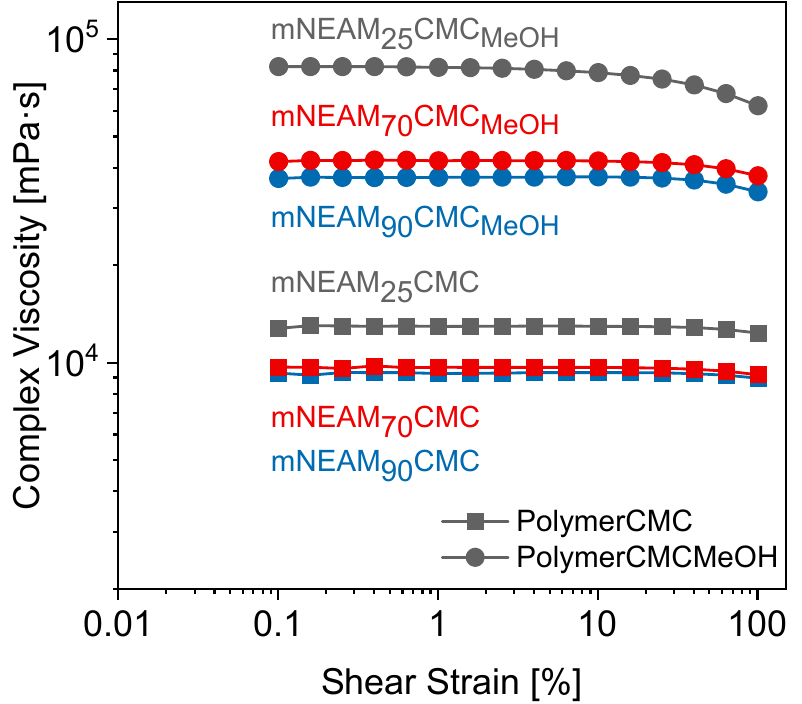
Figure 6. Complex viscosity as a function of shear strain (DSS) for the different blends at 3 °C.